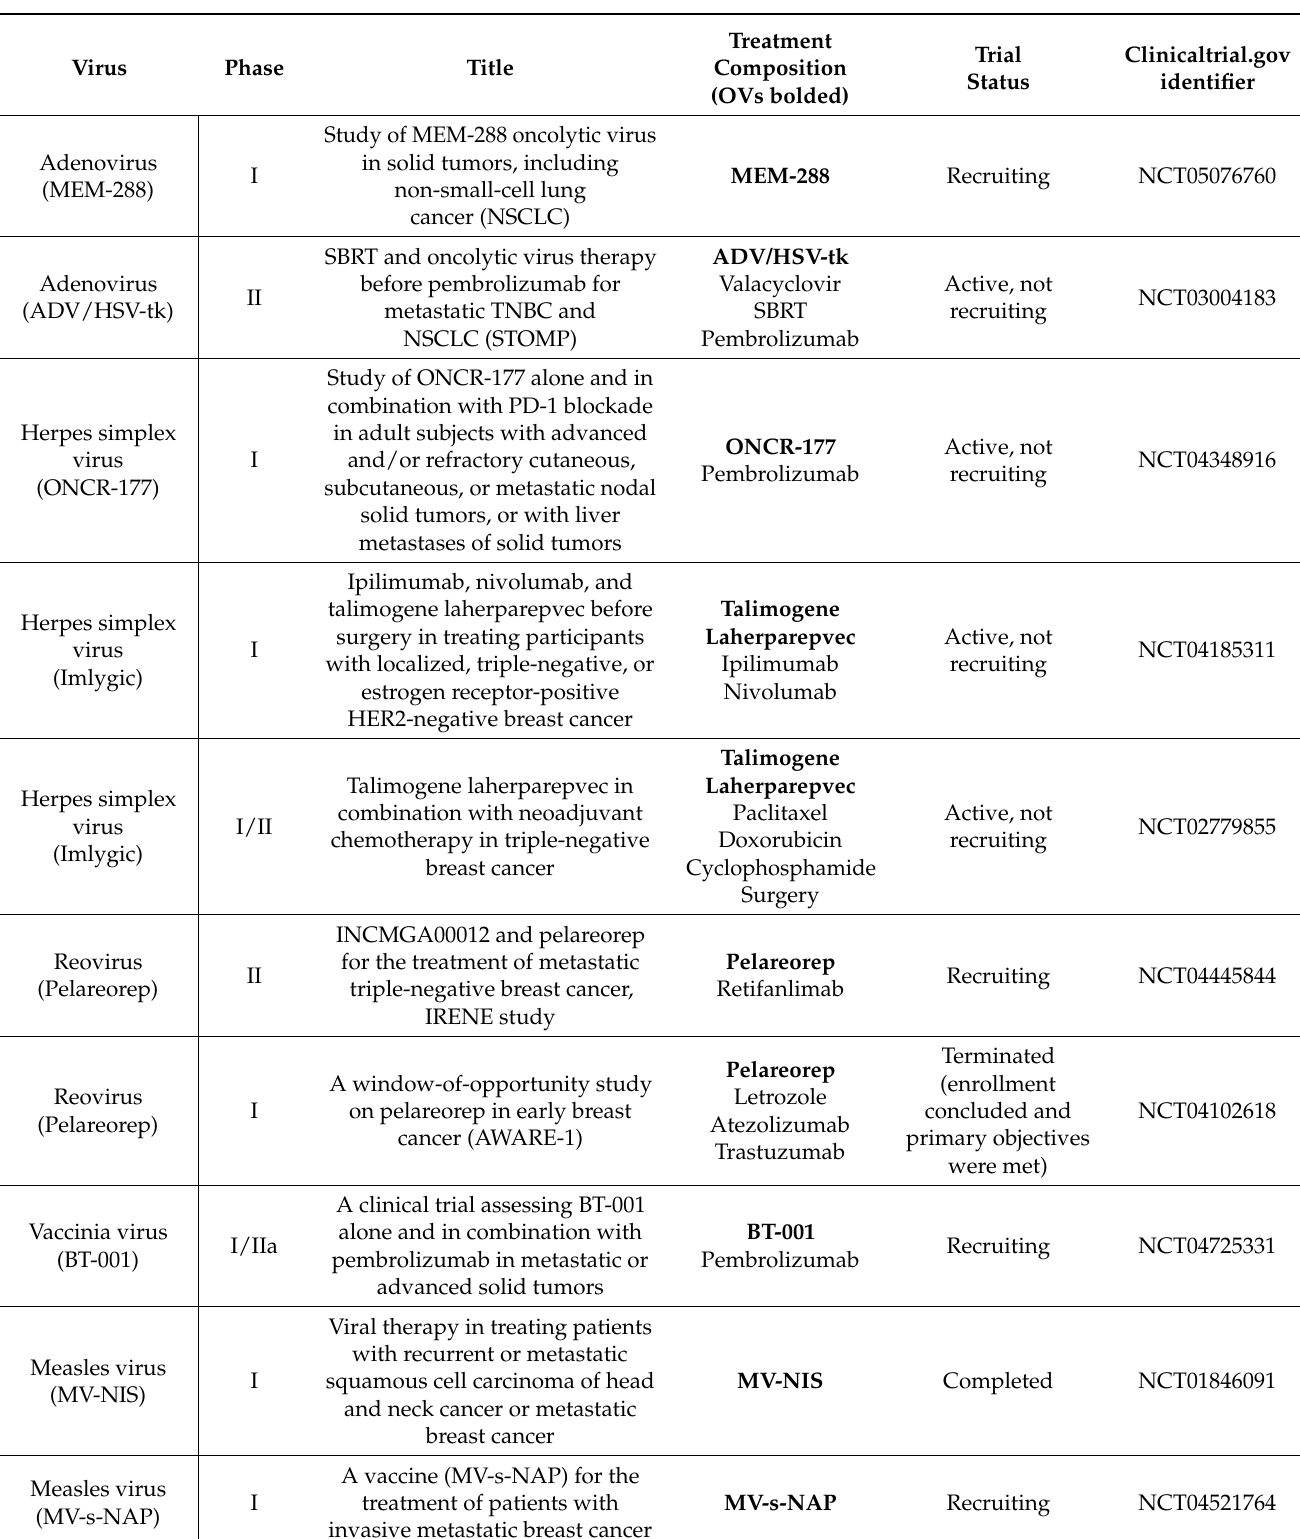
Table 3. Oncolytic viruses being tested clinically in humans against